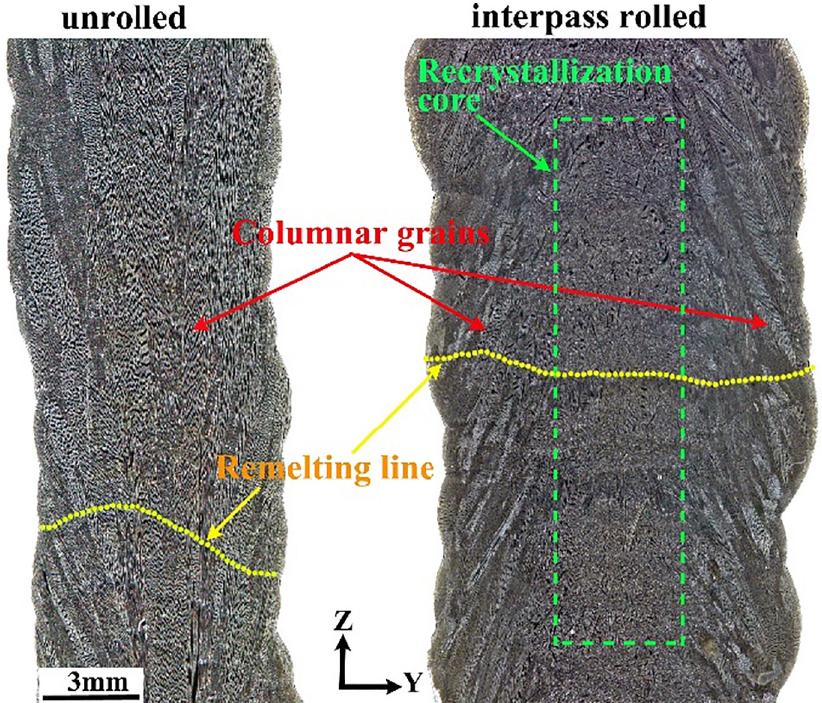
Figure 17. Macrostructure of unrolled and rolled samples. Reprinted from Ref. [61].